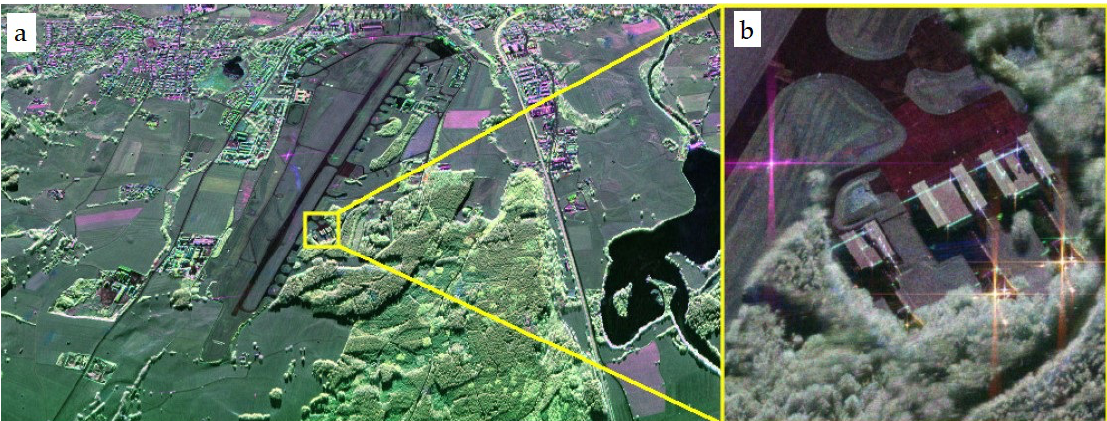
Figure 9. First fully calibrated DBFSAR image, showing the calibration test site of Kaufbeuren ( a ), including a zoom into the small feature marked in yellow to illustrate the high resolution imaging capabilities of DBFSAR. HH = blue, VV = red, and HV = green ( b